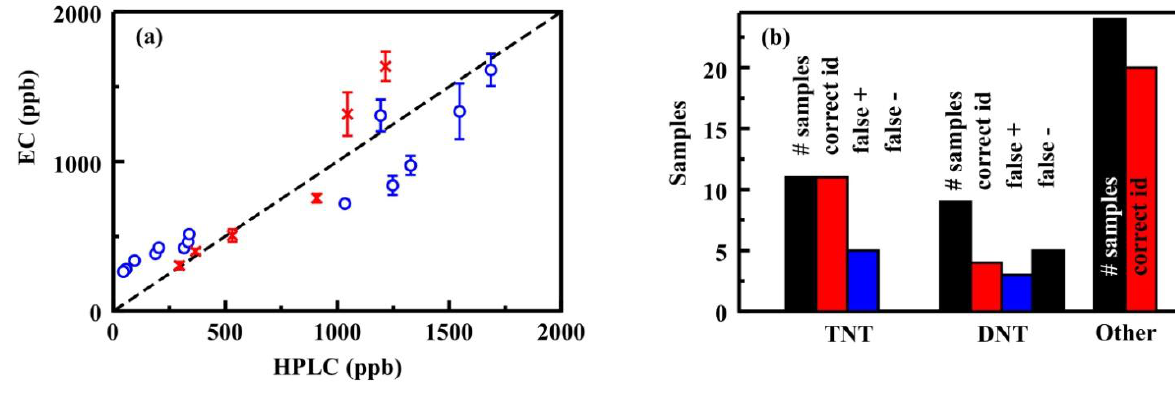
Figure 5. Blind sample analysis for TNT (−0.62 V ±0.02; blue) and DNT (−0.77 ± 0.02; red). ( a ) Points here represent the results for quantification of samples using the prototype system with analysis by HPLC (x-axis) and EC (y-axis). The line indicates the expected results based on HPLC analysis of the spiked samples. Error bars indicate the standard deviation in the measurements; where not visible they are within the size of the symbol. The complete data sets are provided in the Supporting Information, Table S7. ( b ) From the blind sample analysis, the bars shown here indicate the total number